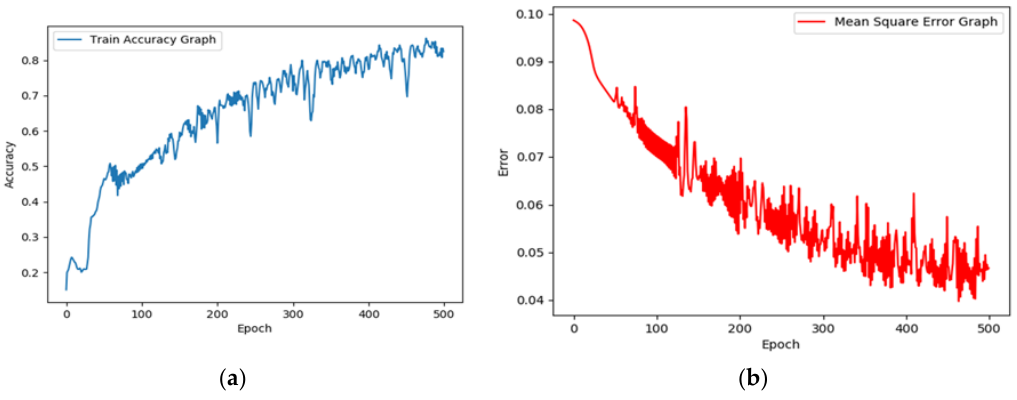
Figure 8. Accuracy and MSE of the CNN algorithm; ( a ) accuracy of the CNN rises continuously with every epoch; ( b ) MSE of CNN reduces with each epoch.